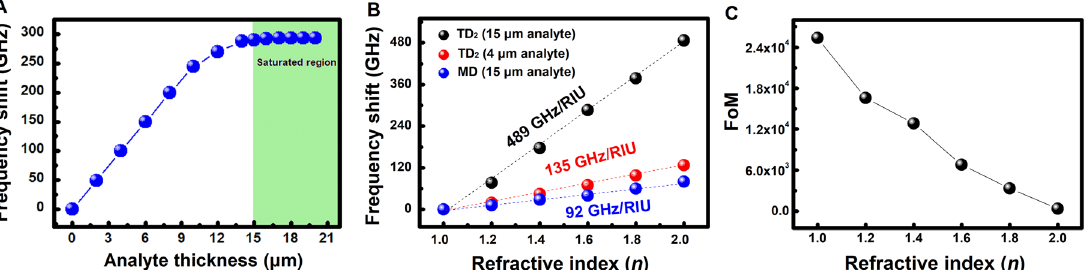
Figure 8: (A) The frequency shift of TD 2 versus the thickness of analyte ( n = 1.6), the green shaded area is saturated region. (B) The frequency shifts of TD 2 with 15 μ m analyte (the black balls) and 4 μ m analyte (the red balls), and of MD with 15 μ m analyte (the blue balls) deposited on the asymmetric metasurface surface versus the refractive index of analyte, the dashed lines are the linear fi ttings. (C) The FoMs of TD 2 with 15 μ m analyte deposited on the asymmetric metasurface surface versus the refractive index of